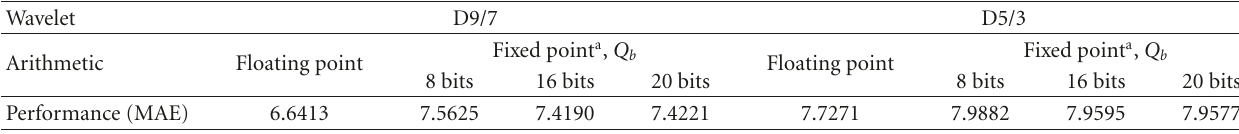
Table 11: Standard wavelets performance for the training image.